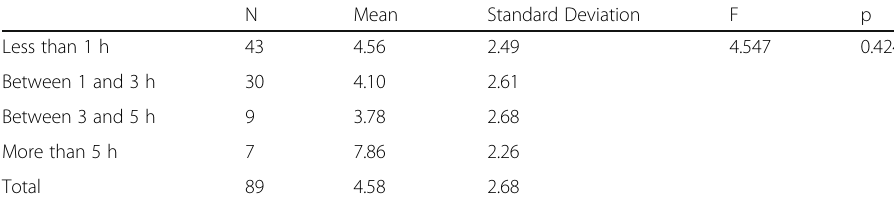
Table 4 ANOVA results for effect of daily average computer use to mental effort N Mean Standard Deviation F p Less than 1 h 43 Between 1 and 3 h 30 Between 3 and 5 h